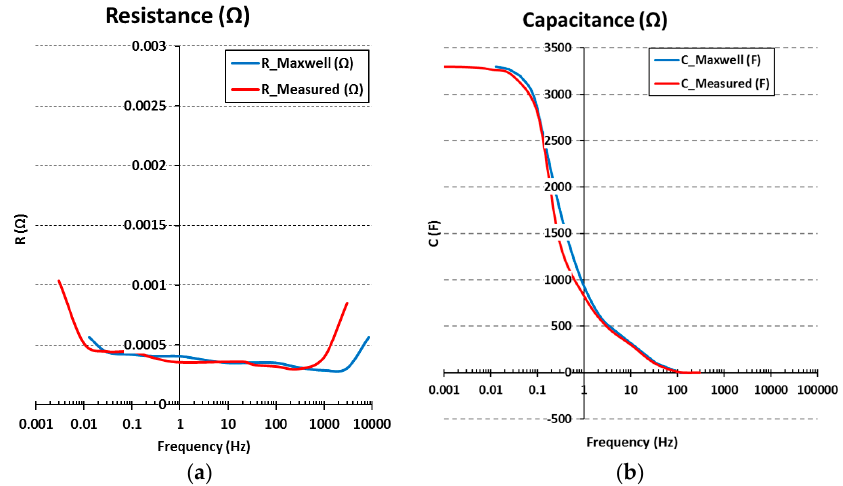
Figure 9. ( a ) SC resistance evolution as a function of the frequency; ( b ) SC capacitance evolution as a function of the frequency. Experimental results and shown in red, while the reference values supplied by the manufacturer are displayed in blue.